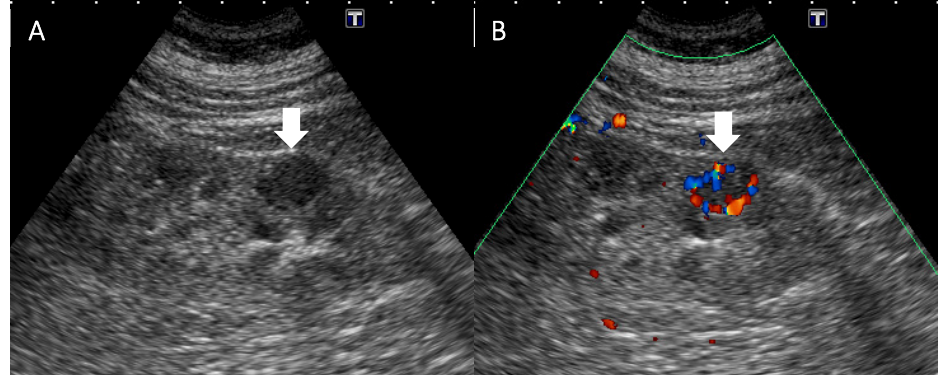
Figure 1. Ultrasonography of this case. ( A ) Ultrasonography reveals a hypoechoic nodule in the renal parenchyma of the right kidney (arrow). ( B ) Color Doppler imaging shows increased peripheral vascularity of the lesion (arrow).